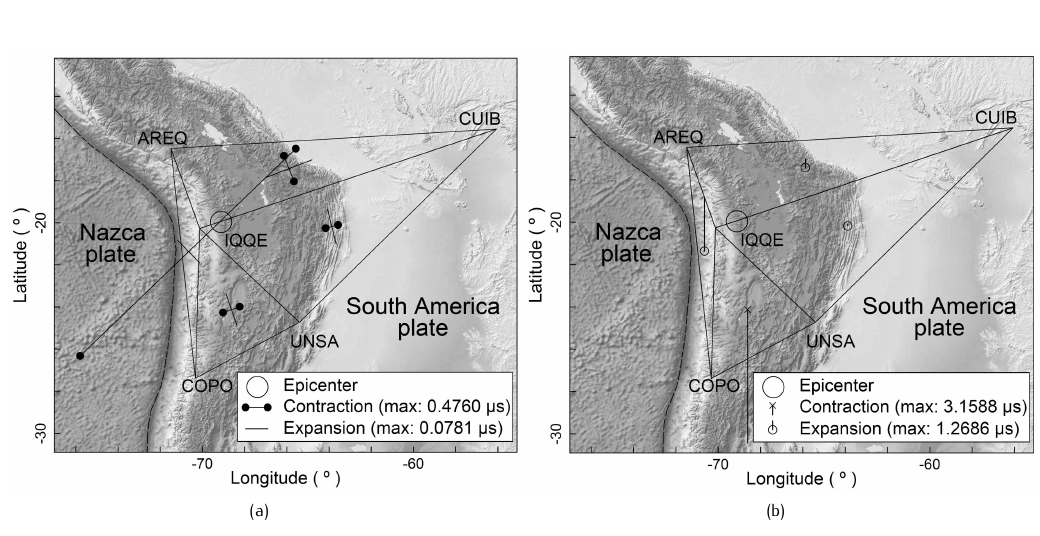
Figure 4. a) Principal components of planimetric strain to the seismic event of 06/13/2005. b) Principal components of altimetric strain to the seismic event of